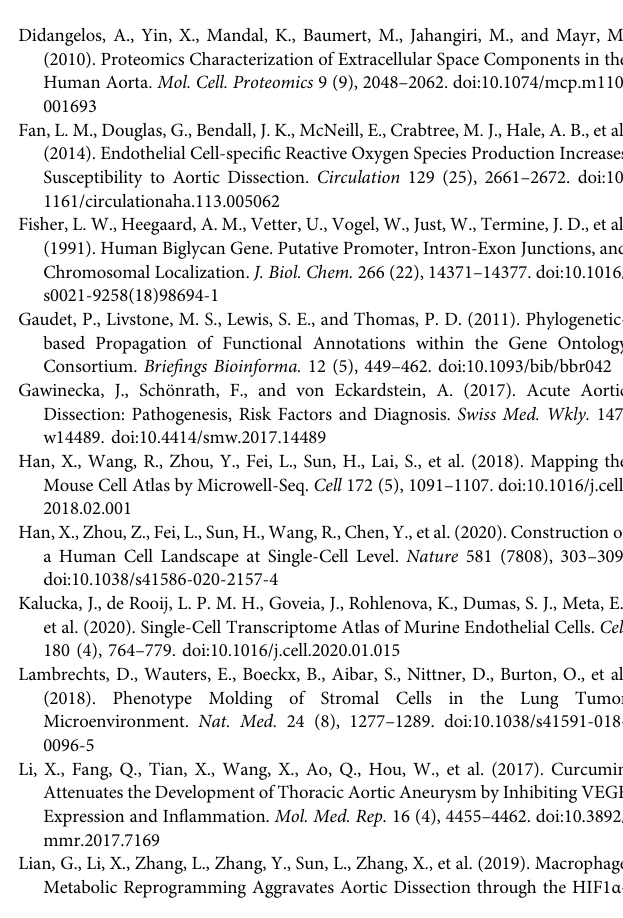
Supplementary Figure S1 | Smooth muscle cell subtype